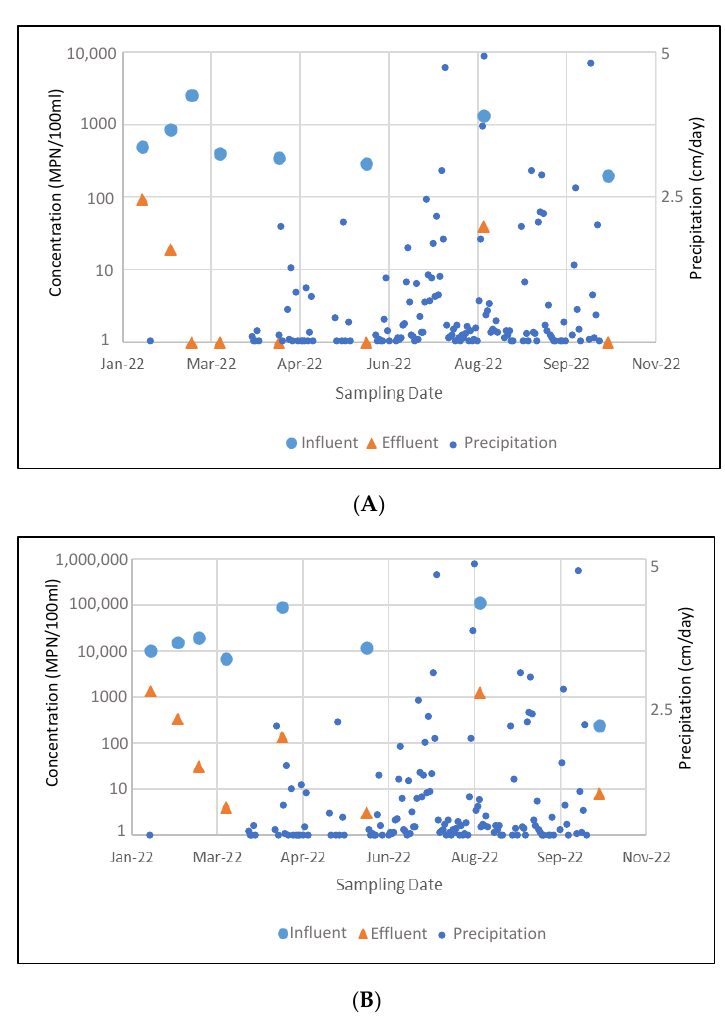
Figure 5. ( A ) E. coli and ( B ) total coliform bacteria measured in the influent water and the effluent from the IBF system. E. coli non-detected values were set to one to permit plotting on log scale. Precipitation data from rain gauges at Belgaum Sambra field station [26].